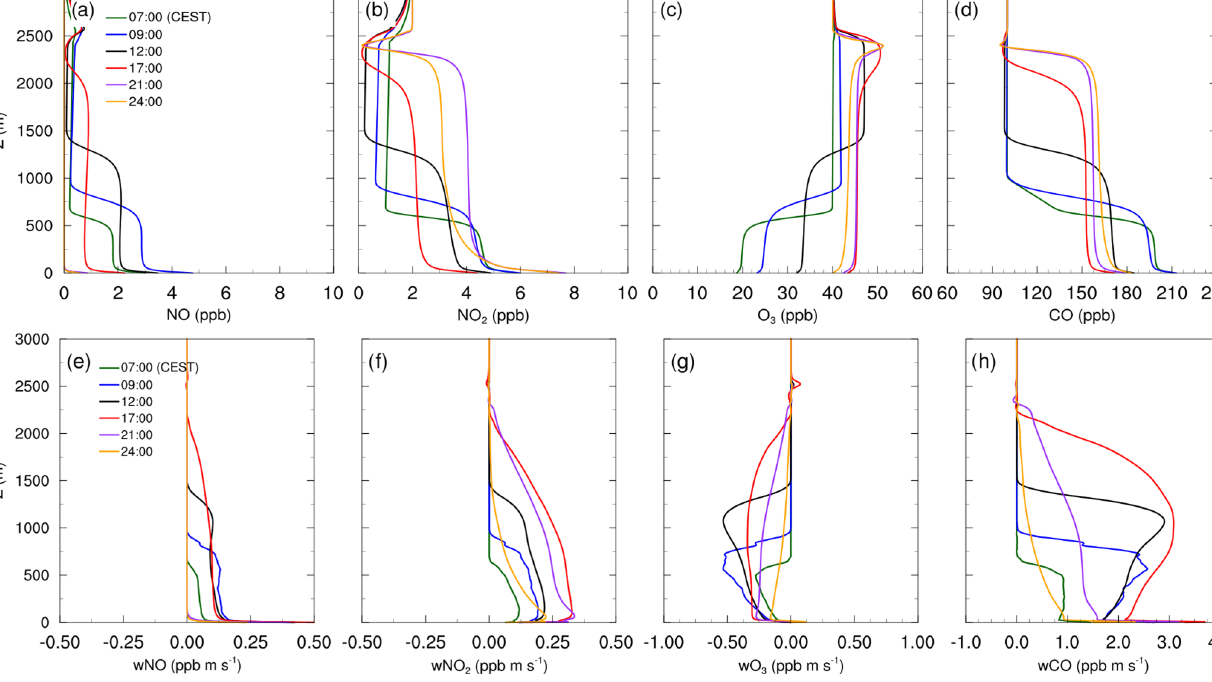
Figure 4. Mean vertical profiles of species concentration for (a) NO, (b) NO 2 , (c) O 3 and (d) CO, as well as their total vertical fluxes (e–h) over the diurnal cycle on 17 July 2017, simulated with the CBM4